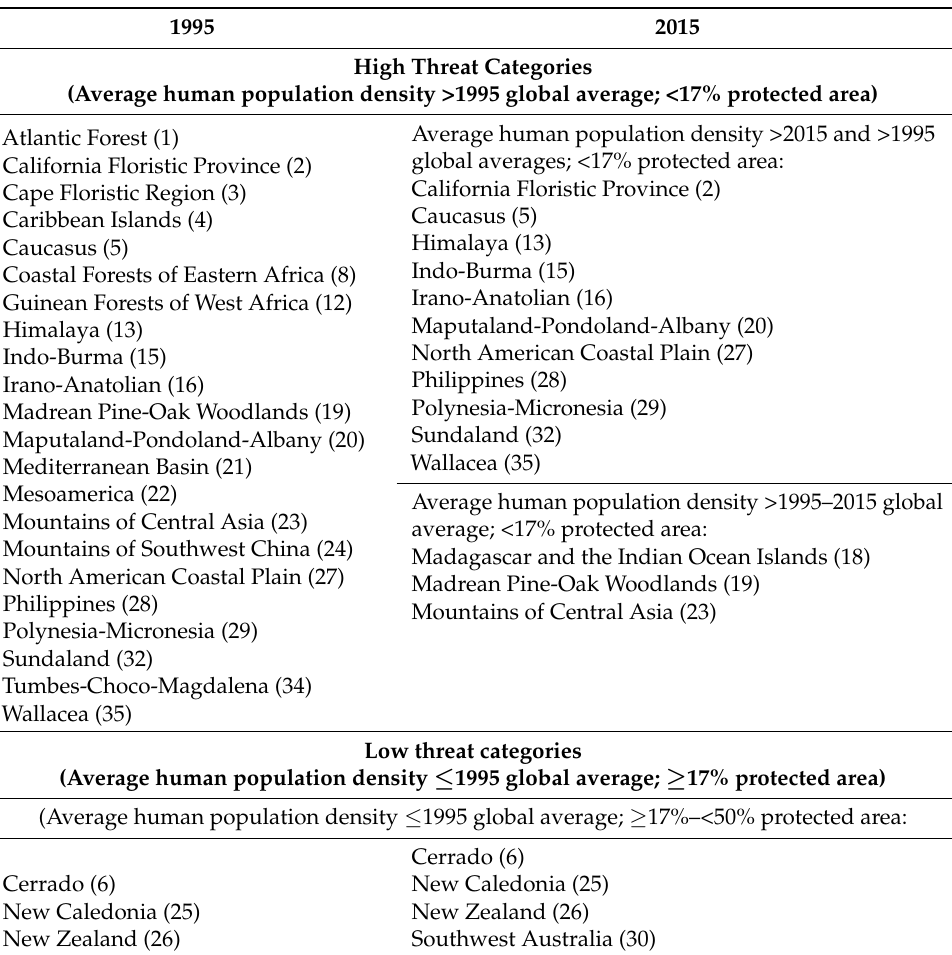
Table 1. Biodiversity hotspots falling within high- and low-threat categories in analyses based on average human population densities relative to global average and protected area relative to 17% and 50% targets in 1995 and 2015, as shown in Figures 2 and